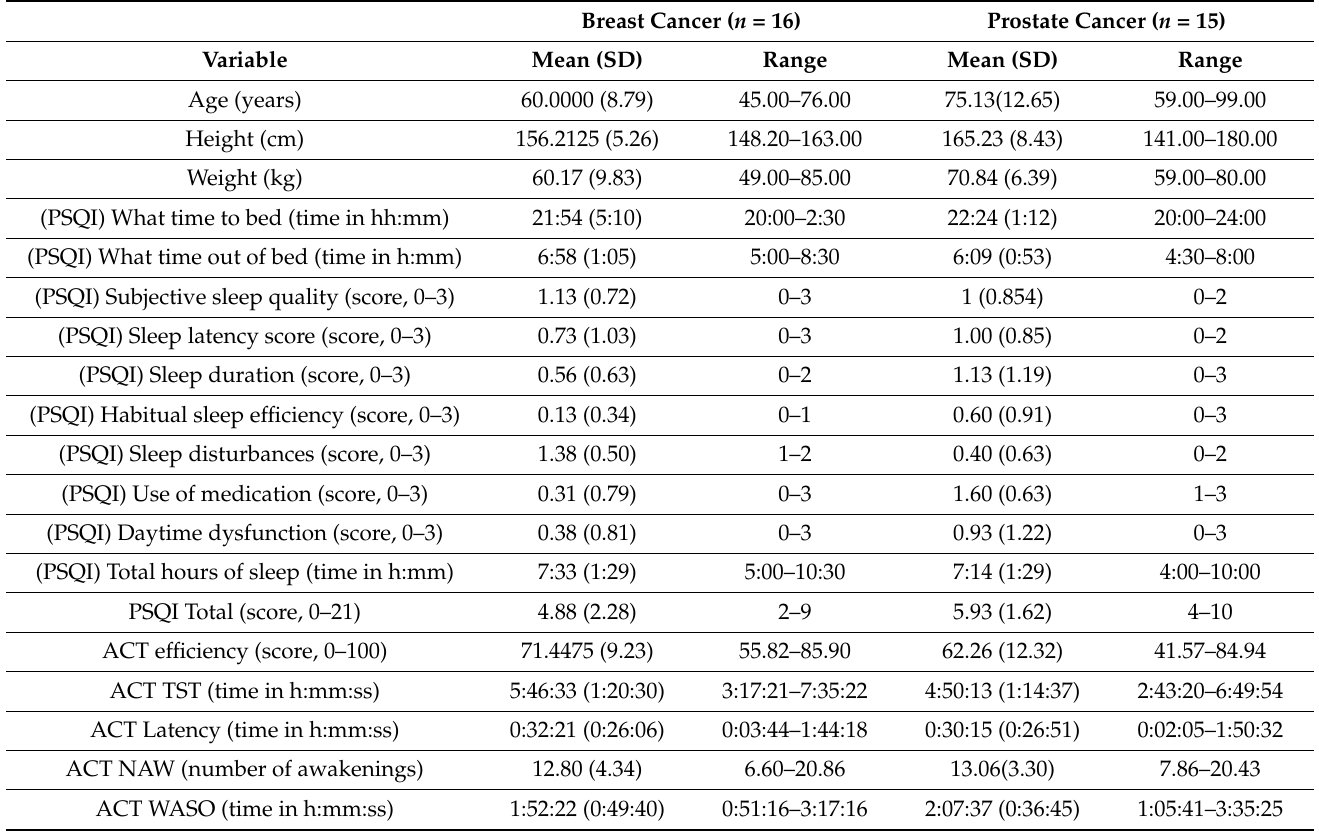
Table 1. Descriptive statistics for the study variables in breast and prostate cancer. Breast Cancer ( n = 16) Prostate Cancer ( n =